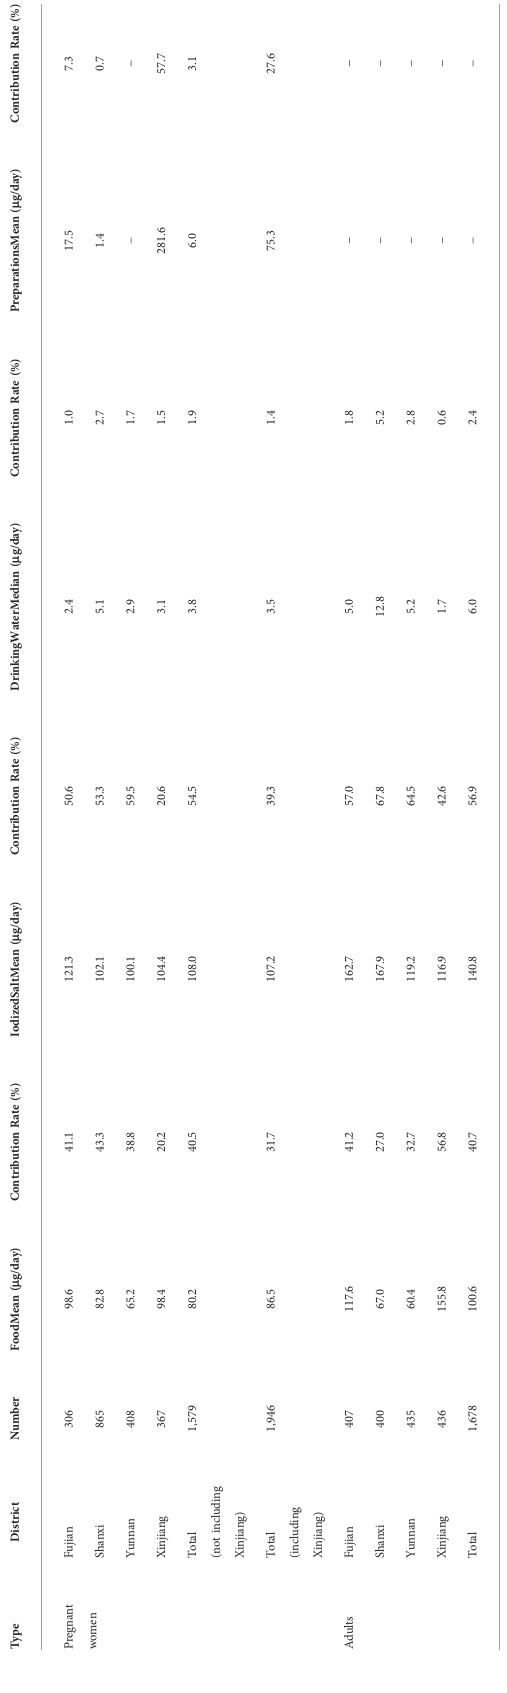
(Figure 6B), adults had the larger proportion of breakfast at home (72.10%) and street food (7.73%). Different